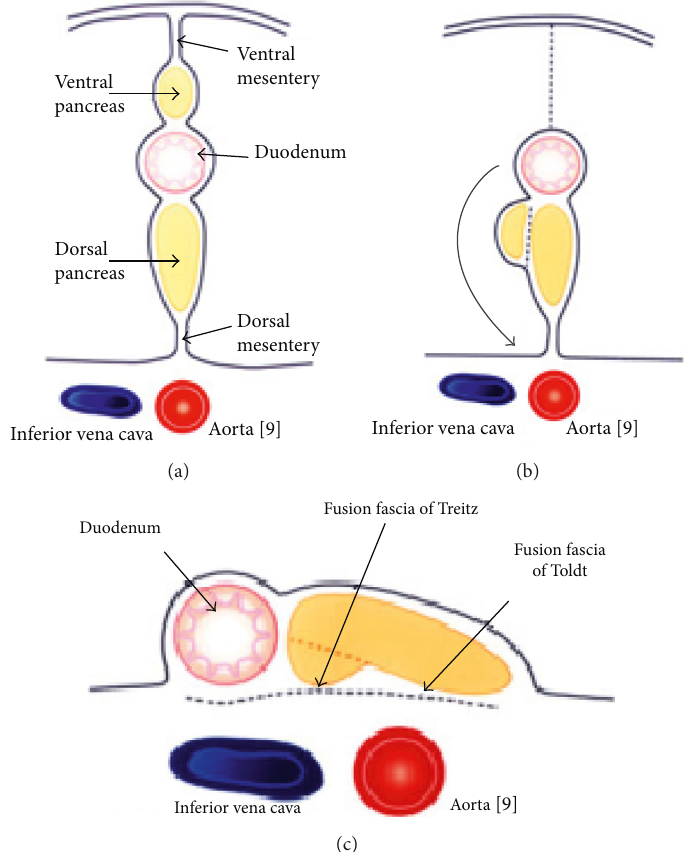
Figure 6: Embryological formation of the surgical planes allowing the distal pancreatectomy as described. Rotating around the duodenum ventral pancreas and the dorsal pancreas form the pancreas. The rotation of the pancreas and the duodenum cause the fusion of fascias of Toldt and Treitz